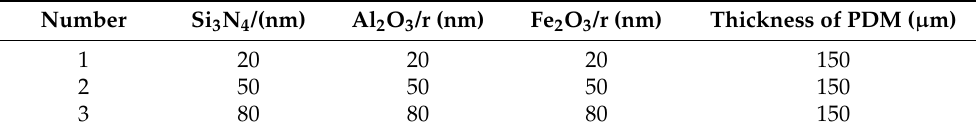
Table 2. Different diameter of different particles are added to PDMS.